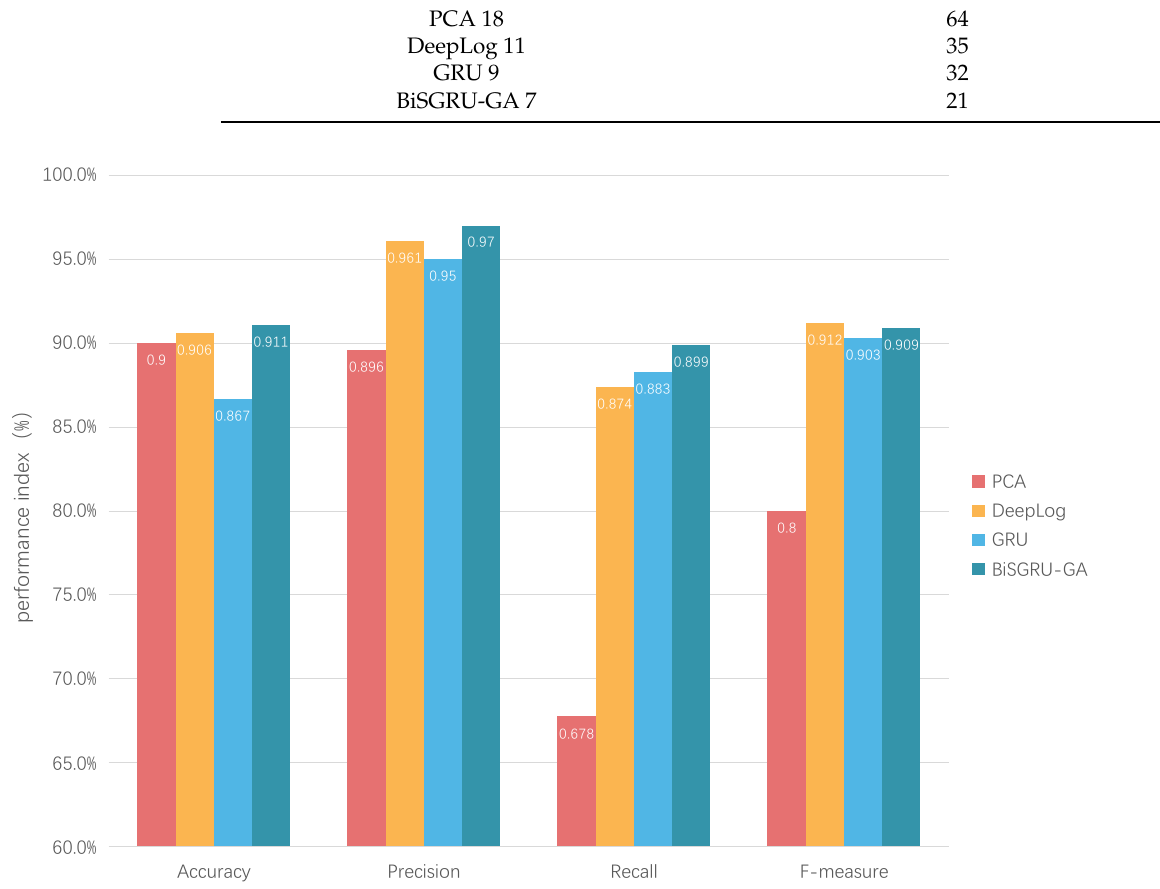
Figure 11. Experimental results of anomaly detection model performance comparison.